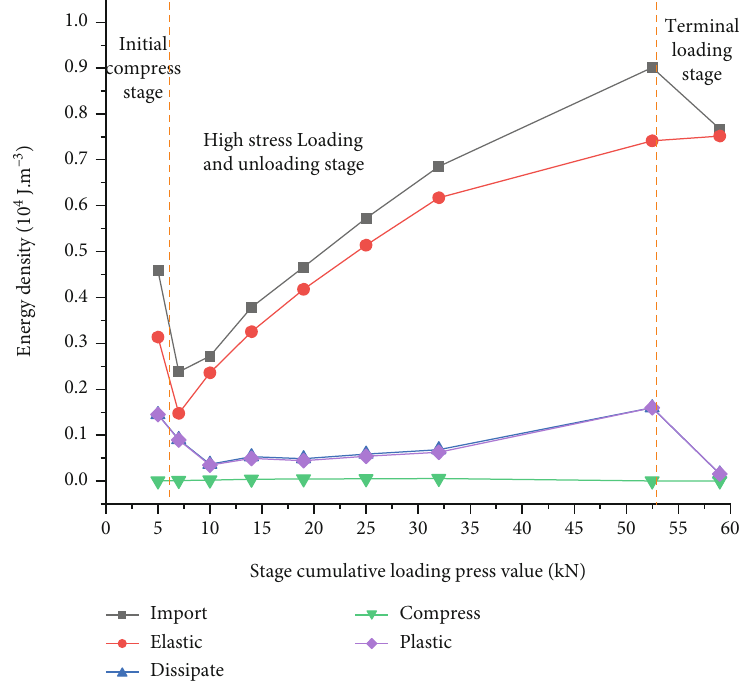
Figure 12: Relationship between energy density and stage cumulative loading press value with sample B1.